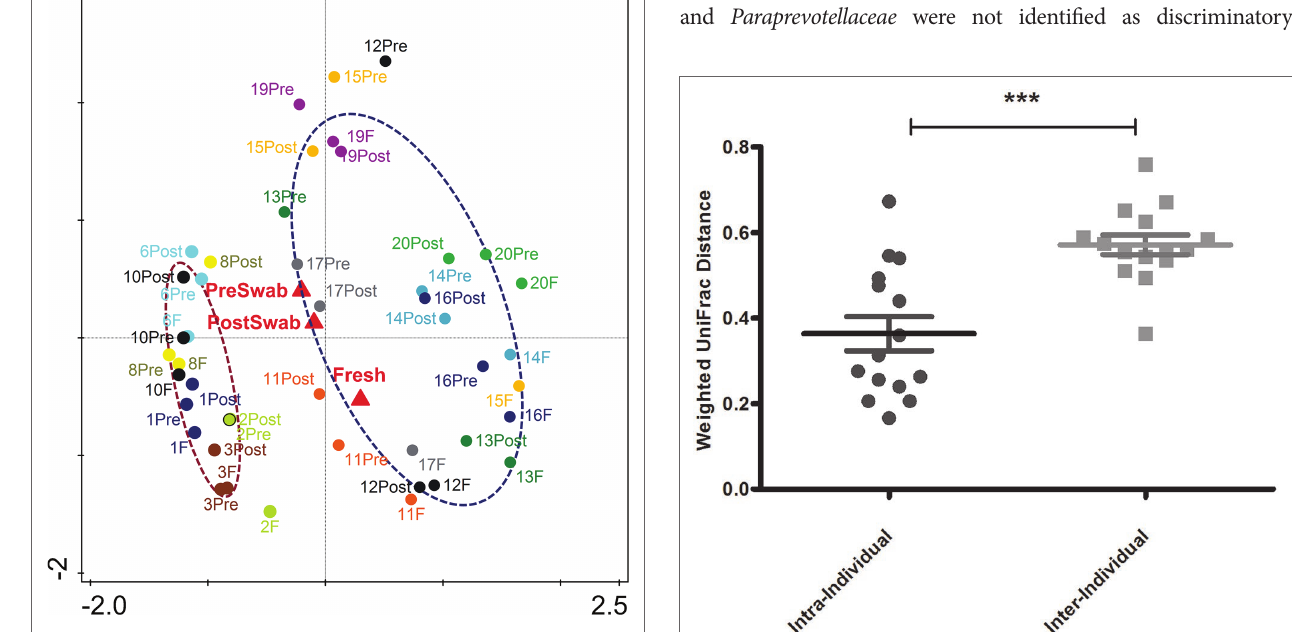
FIGURE 4 | Mean pairwise Weighted UniFrac distance reflecting sample to sample variation within animal (Intra-individual) and between animal (inter-individual). Averaged weighted UniFrac distances indicated that inter- individual variation is greater than intra-individual variation (*** p <